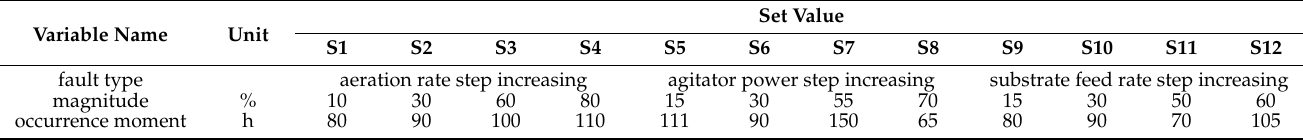
Table 2. The details of test samples 1~12.